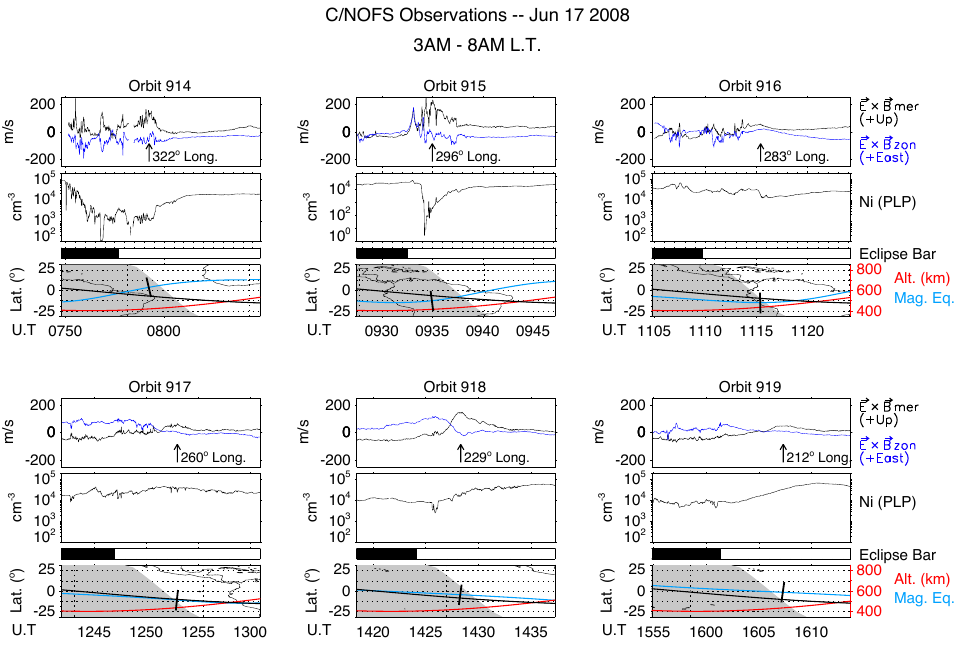
Figure 3. Same as Fig. 2, except that the data are enlarged for the periods of 03:00–08:00LT. Furthermore, the grey shading in the lowest panel corresponds to the shadow of the Earth at 100km